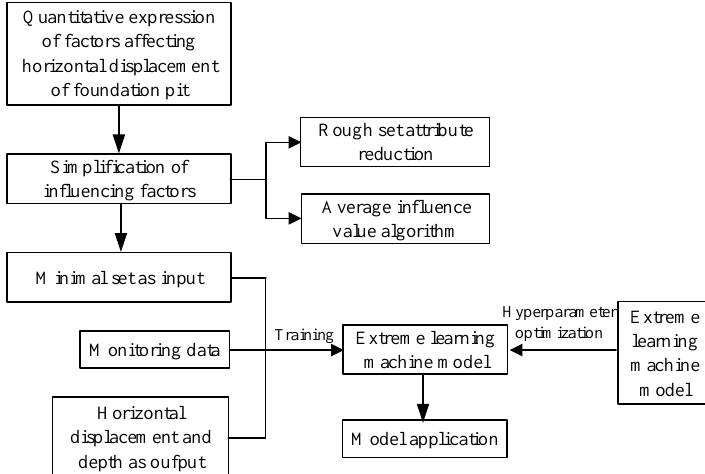
Figure 3. IPM of foundation pit displacement.